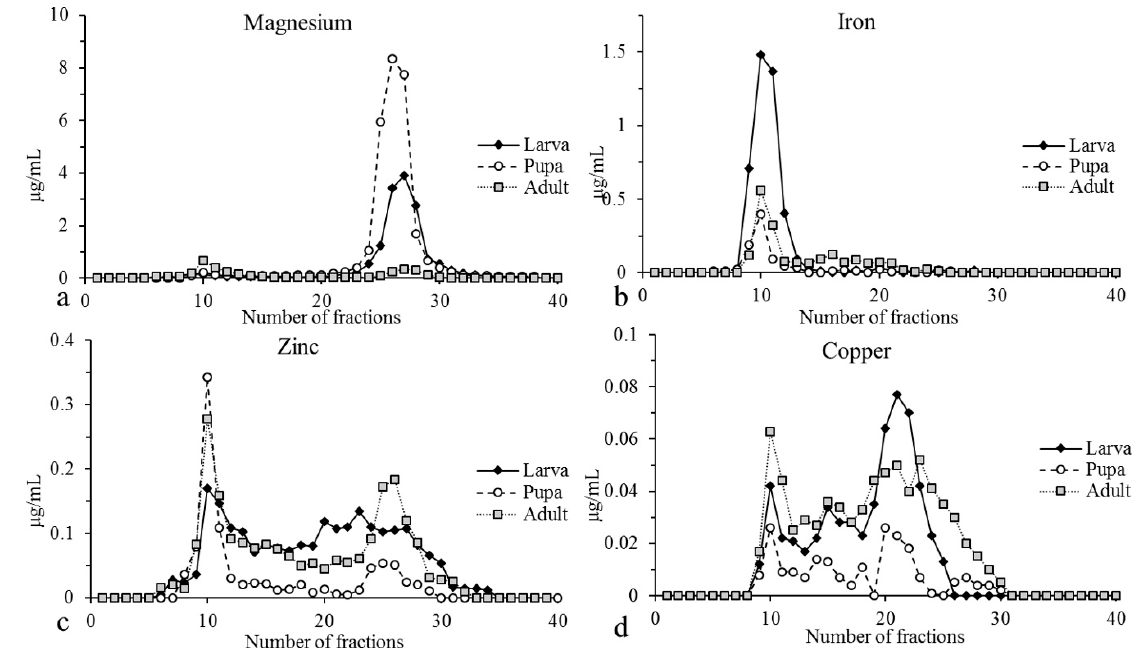
Figure 1. Element profiles of the cytosolic extracts obtained from the larvae, pupae and adults after size exclusion chromatography. The element concentrations are expressed in µg/mL.